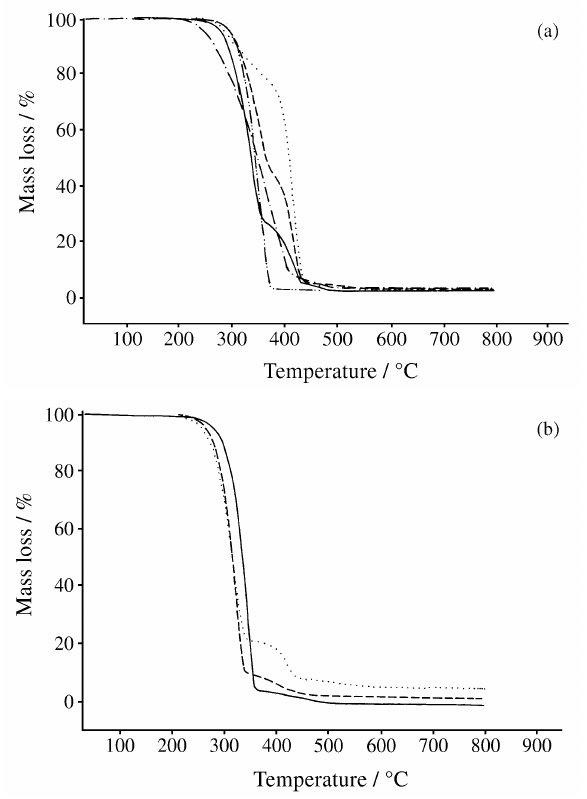
Figure 2. (a) Thermogravimetric curves of (-..-..-) pure PLLA, (-.-.-) pure PEO, (–) 80/20, (- - -) 50/50 and (. . . .) 20/80 PLLA/PEO blends (t = 0). (b) Thermogravimetric curves of (–) 80/20, (- - -) 50/50 and (. . . .) 20/80 PLLA/PEO blends (t = 14 days).